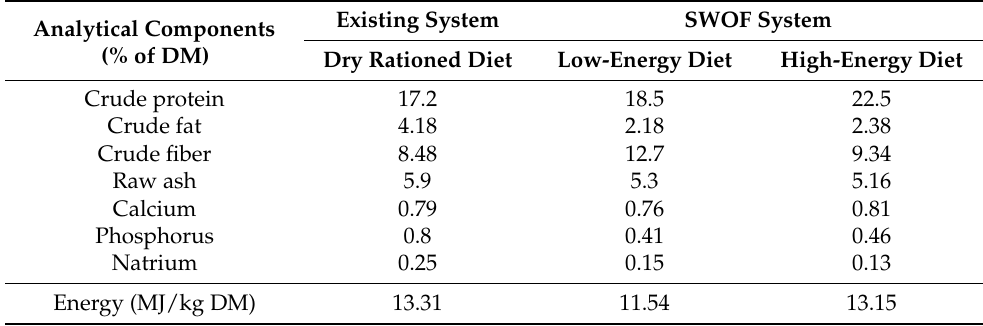
Table 2. Chemical composition and energy content of the diets in the existing and the SWOF system. Analytical Components